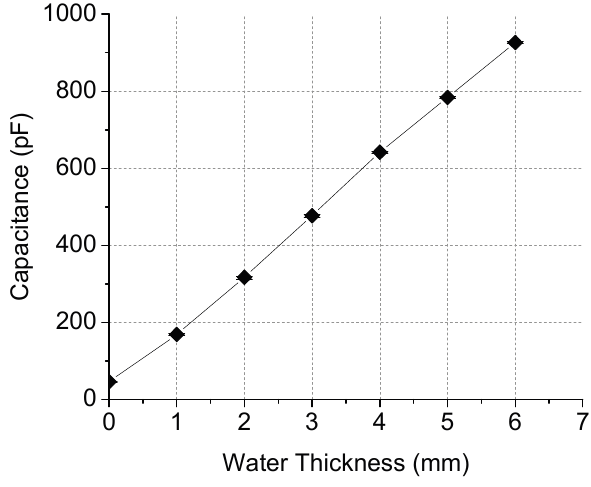
Figure 3. Measurement of capacitance for an increasing water height by using the fabricated ice